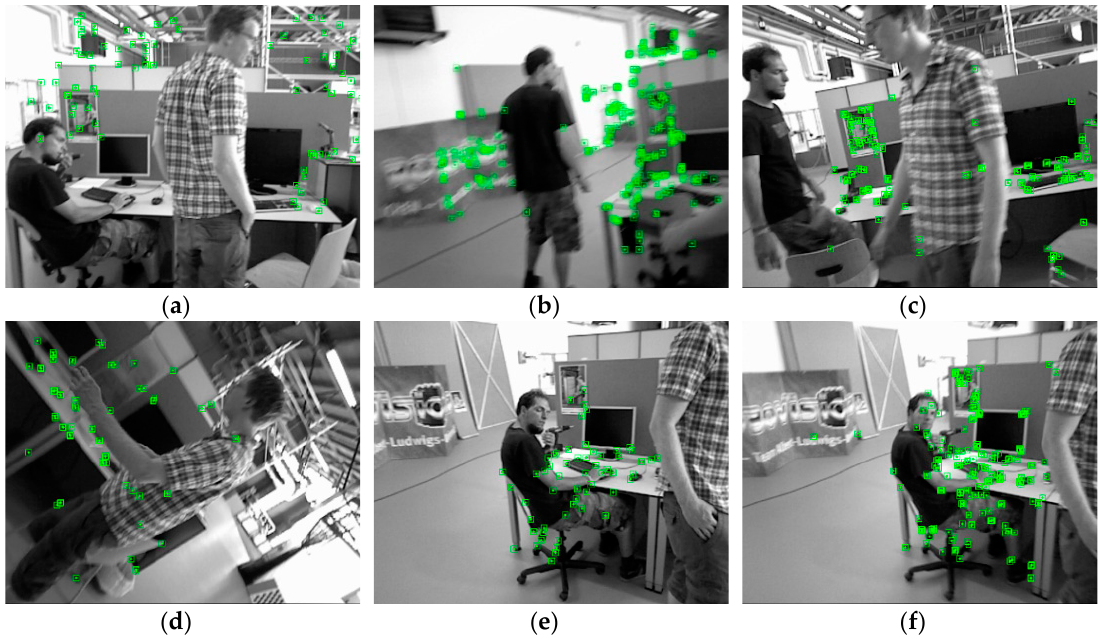
Figure 6. The features used for solving camera pose in the tracking thread, which are marked with green circle. ( a – f ) show performance of static features extraction of our algorithm in several typical motion scenes.